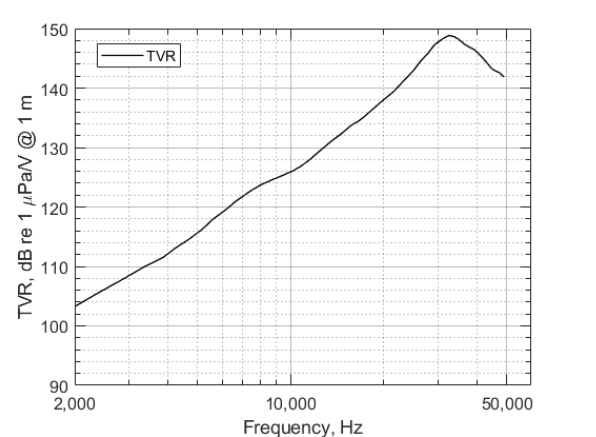
Figure 7. Transmitting voltage response of the ITC-1032 (from product data